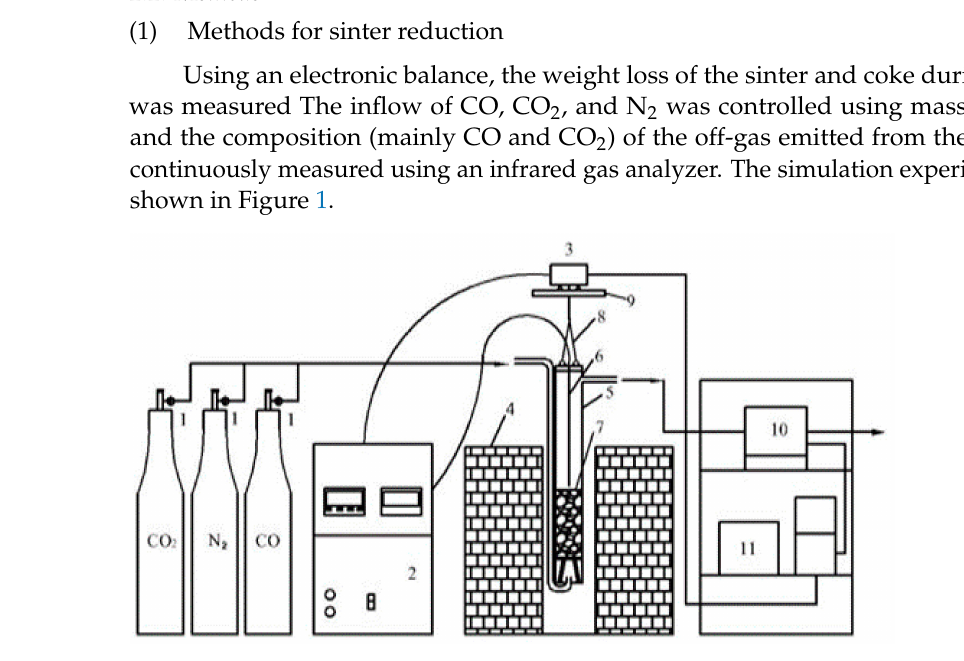
Figure 1. Schematic diagram of hanging high-temperature furnace for simulation